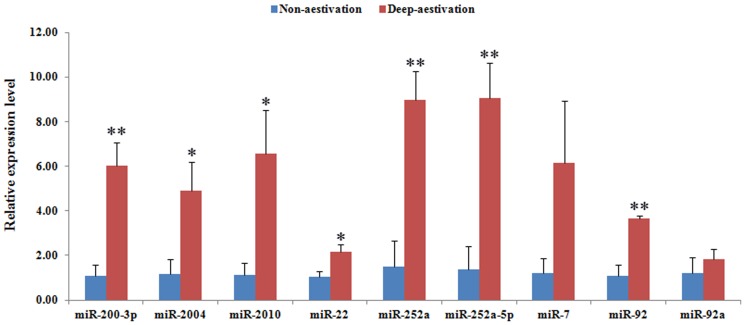
Real-time PCR validation of differentially expressed miRNAs supported by both Solexa sequencing and microarray.NA, non-aestivation; DA, deep-aestivation (n = 3 for NA and DA respectively). The RT-PCR was performed in triplicate wells for each individual sample. Bars show means ± standard deviation. “*” p<0.05; “**” p<0.01.